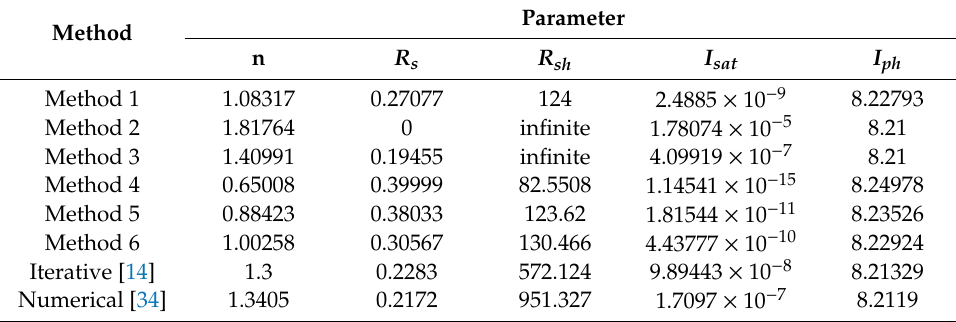
Table 2. Parameters for the Multicrystalline (Kyocera